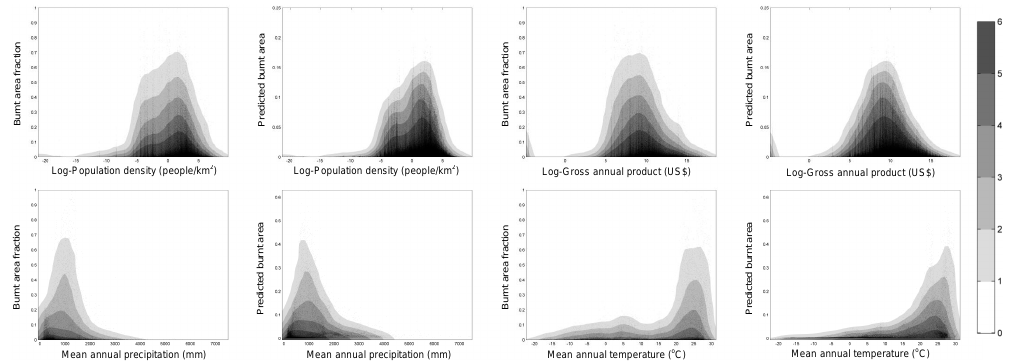
Figure 4. Emergent patterns: predicted probabilities against mean annual temperature (MAT), mean annual precipitation (MAP), ln (popu- lation density) and ln (GDP per unit area). We show the density of the data superimposed onto logarithmic density using 50